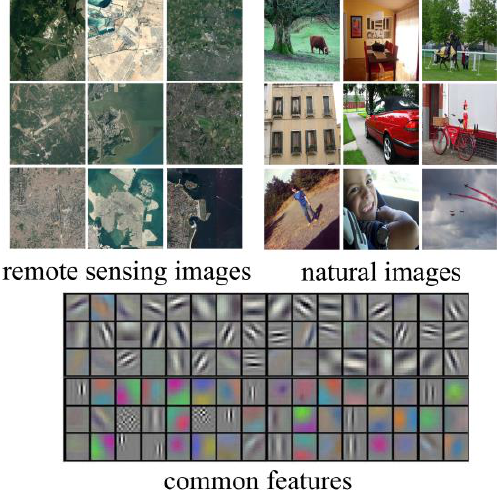
Figure 4. Schematic diagram of transfer learning.